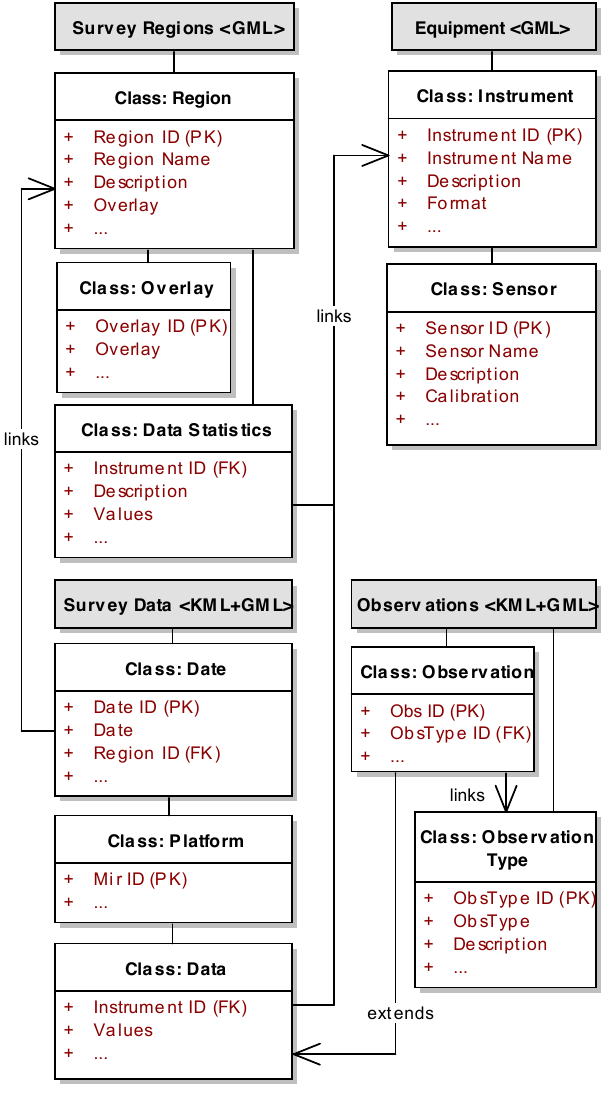
Figure 7: Semantic diagram of the ´El´emo project